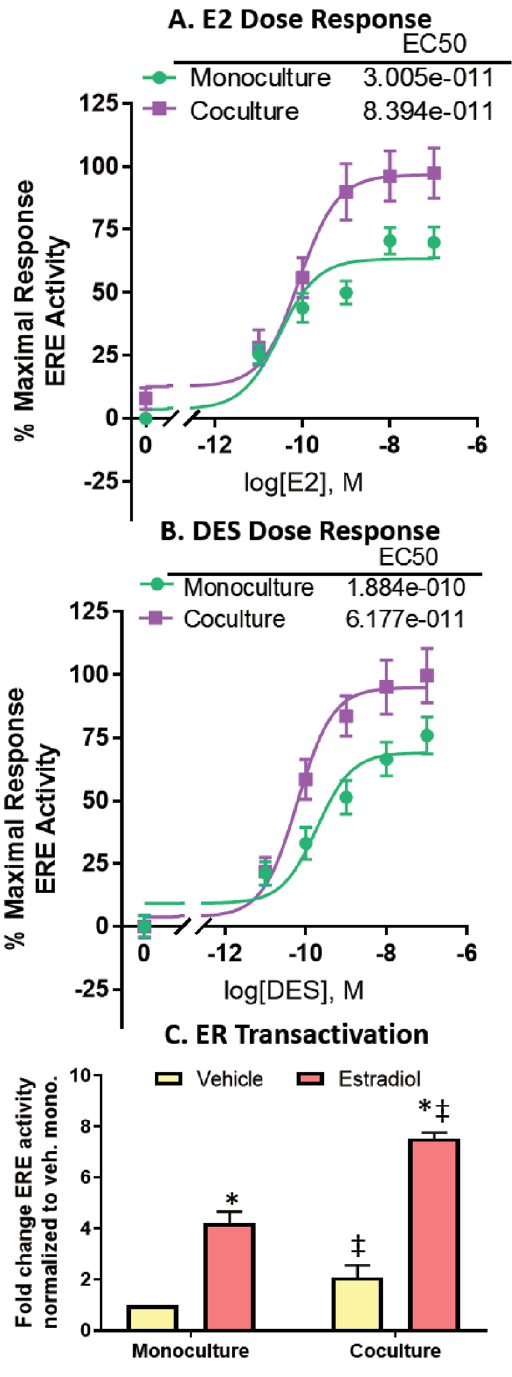
Figure 4. MCF7-derived ducts respond to ER ligands in a dose-dependent manner, and fibroblasts regulate ER transactivation. ER transactivation was evaluated after cultures were exposed to 5 doses of ( A ) E2 and ( B ) DES for 24 hours. EC50s were generated using nonlinear regression. ( C ) ER transactivation in monoculture and co- culture with fibroblasts was evaluated after 48 hours of exposure to a vehicle or 100 nM E2. Luminescent signal was normalized to the total number of nuclei to account for differences in cell number. A two-way ANOVA was run to evaluate interactions between conditions, followed by a Tukey’s multiple comparisons test to identify significant differences. * = vs. respective vehicle (p < 0.05) and ‡ = vs. respective monoculture (p < 0.05). Graphs represent data from three independent